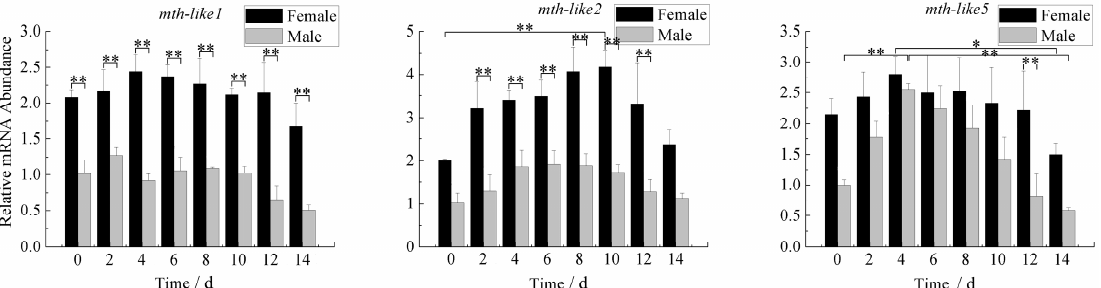
Figure 8. Expression profiles under the stress of starvation. The relative expression indicates the level of each mth-like transcript normalized to the internal standard of α –tubulin, compared to the expression level of the first group (0 day). 0–14 days means the starving time of adults. Data are shown as the mean ± SD. Asterisks indicate differences that are statistically significant (*, p < 0.05; **, p < 0.01).